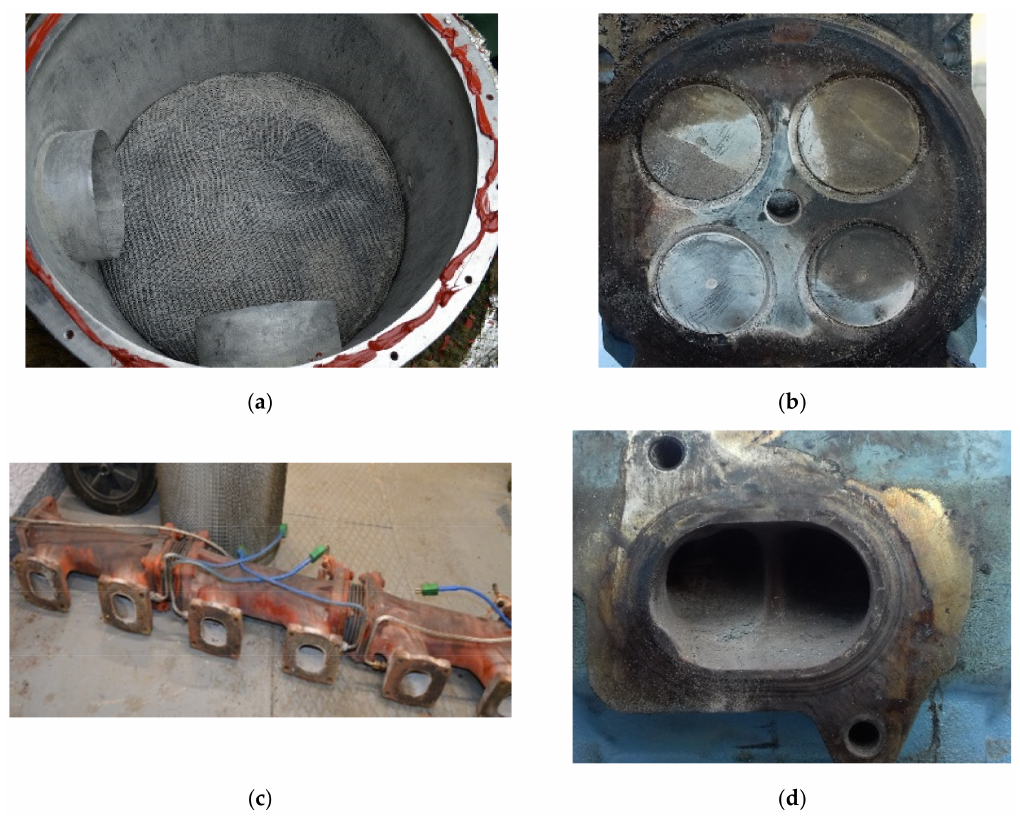
Figure 2. Deposits formed on different parts of engines: ( a ) fabric filter in front of the gas engine, ( b ) valves and ( c , d ) exhaust manifold.